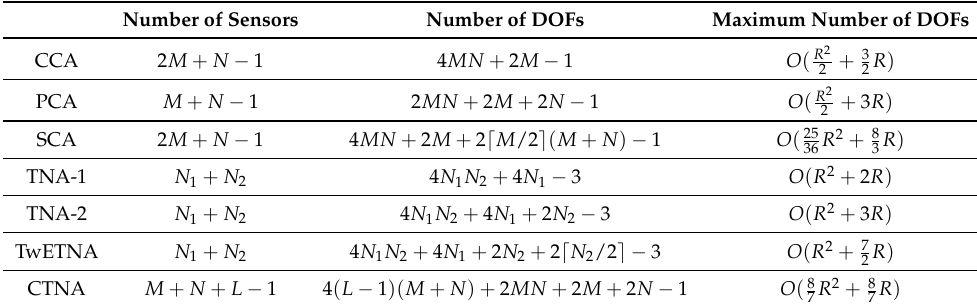
Table 2. DOF comparison of different sparse